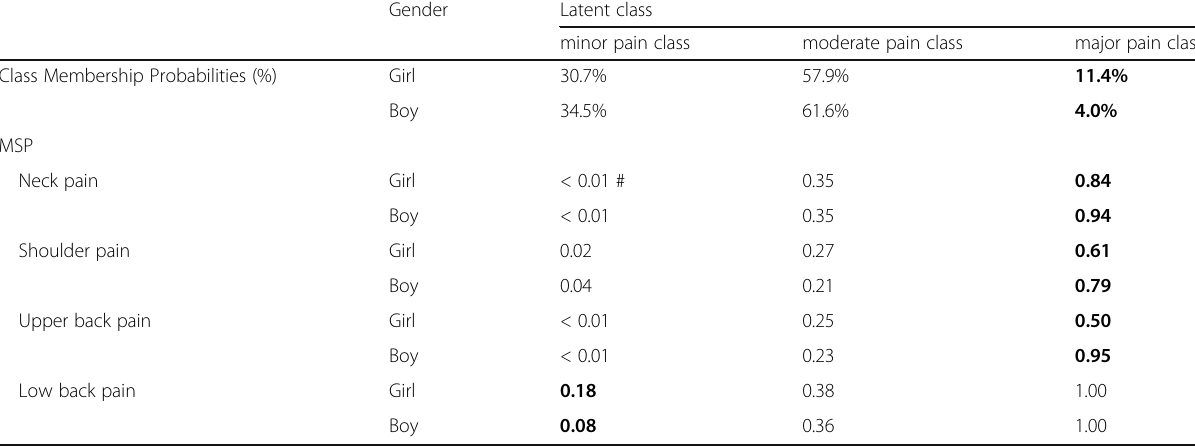
Table 3 Membership and item response probabilities in gender-specific LCA modeling